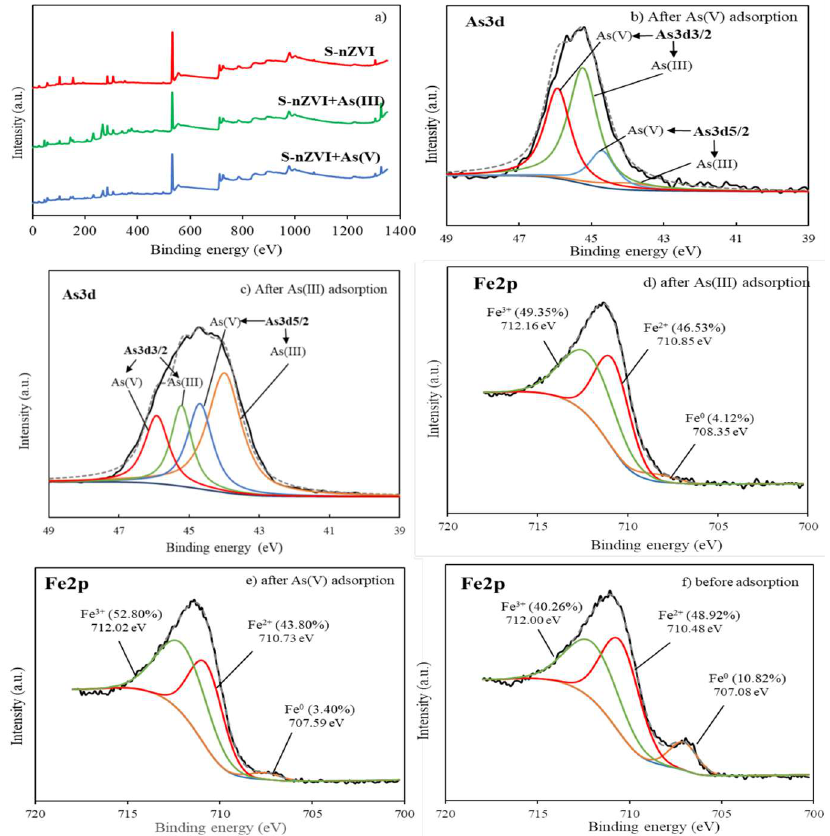
Figure 4. XPS wide-scan spectra ( a ), As3d spectra after As(V) adsorption ( b ) and As(III) adsorption ( c ); and Fe2p spectra after As(III) adsorption ( d ), after As(V) adsorption ( e ), and before adsorption ( f ).